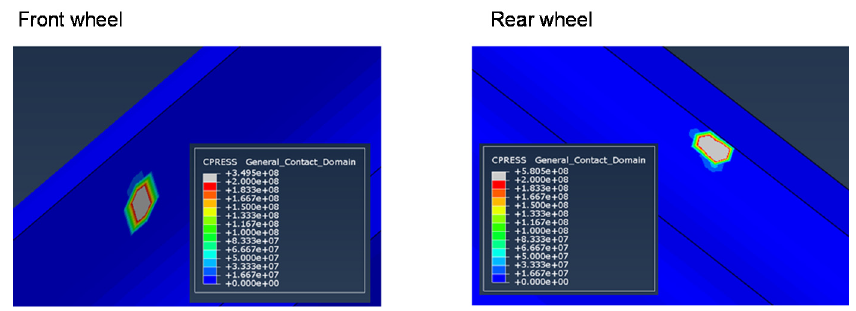
Figure 15. Maximum contact pressure in the rail.